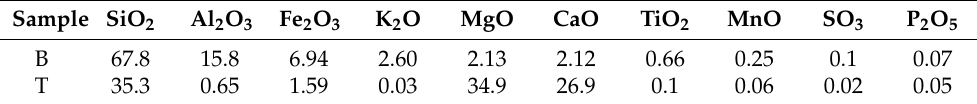
Table 4. Chemical composition (wt.%) of inorganic amendments using